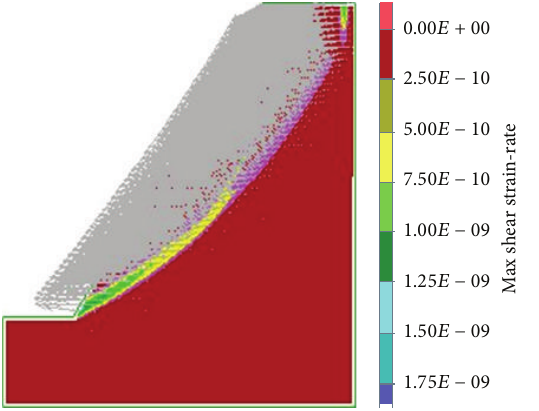
Figure 11: Result of the generally used strength reduction method for the rock